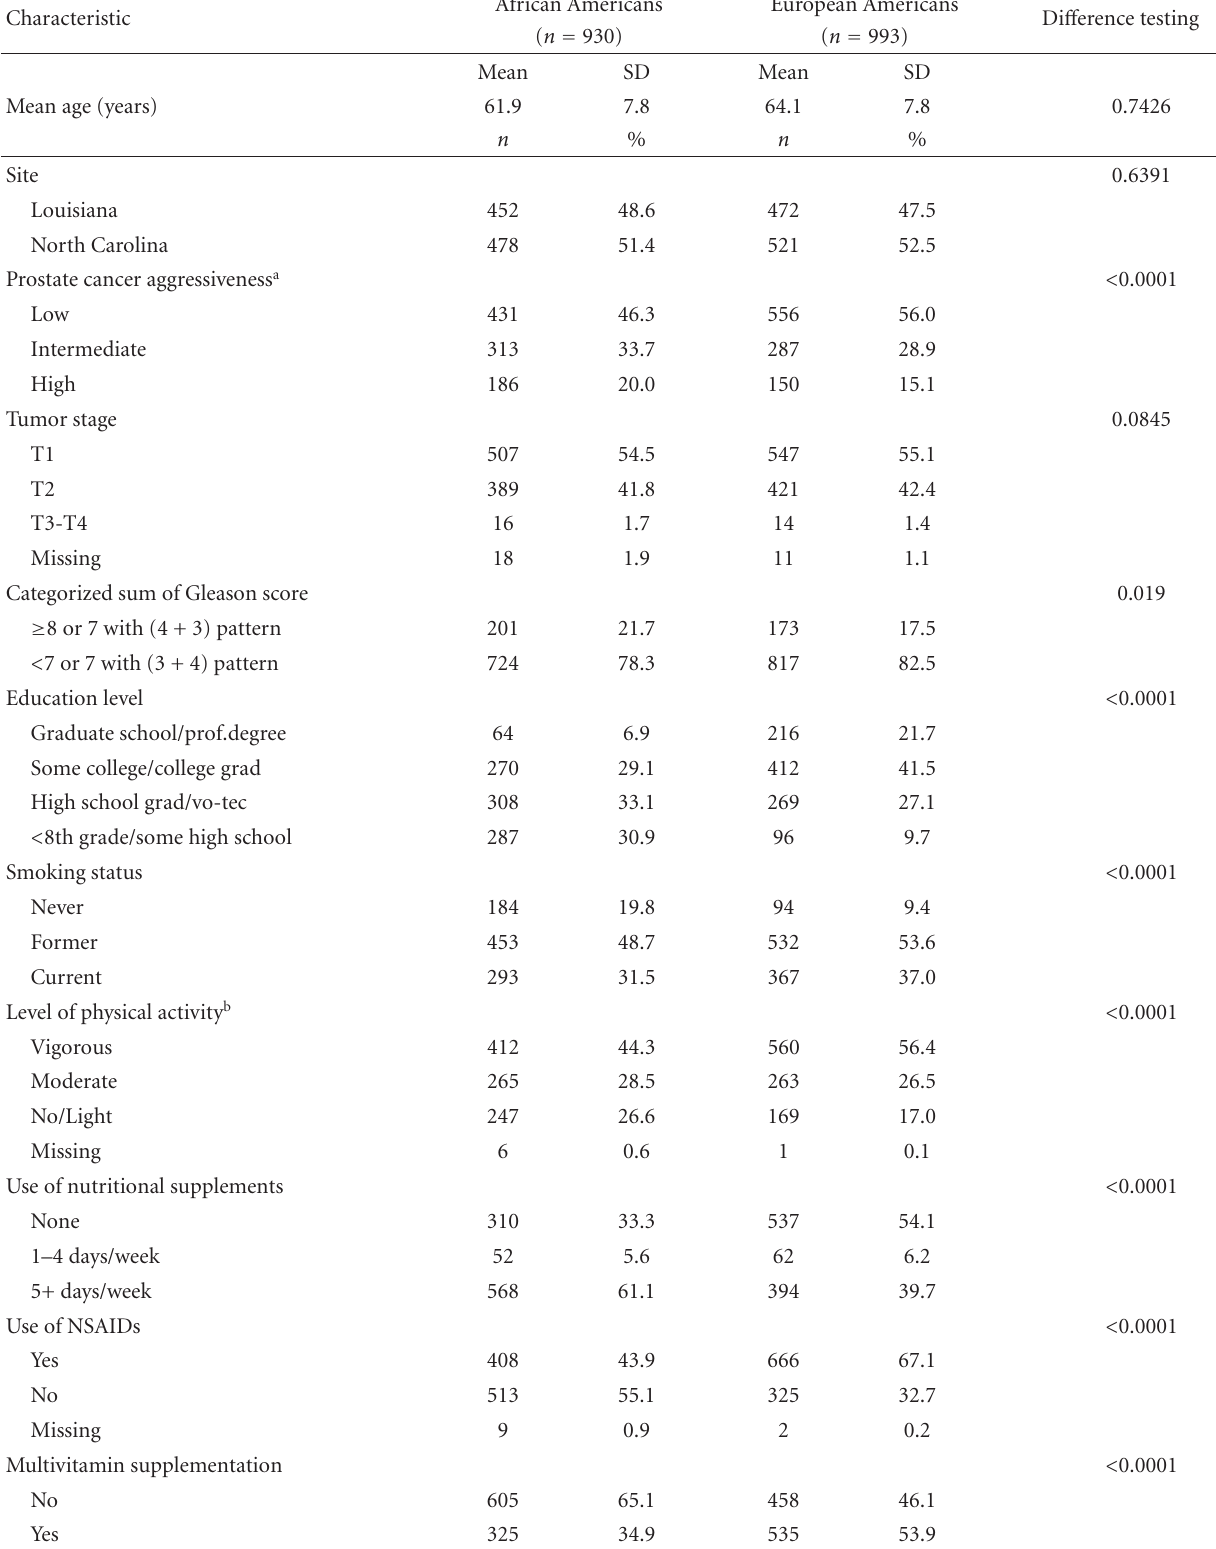
Table 1: Characteristics of prostate cancer cases by